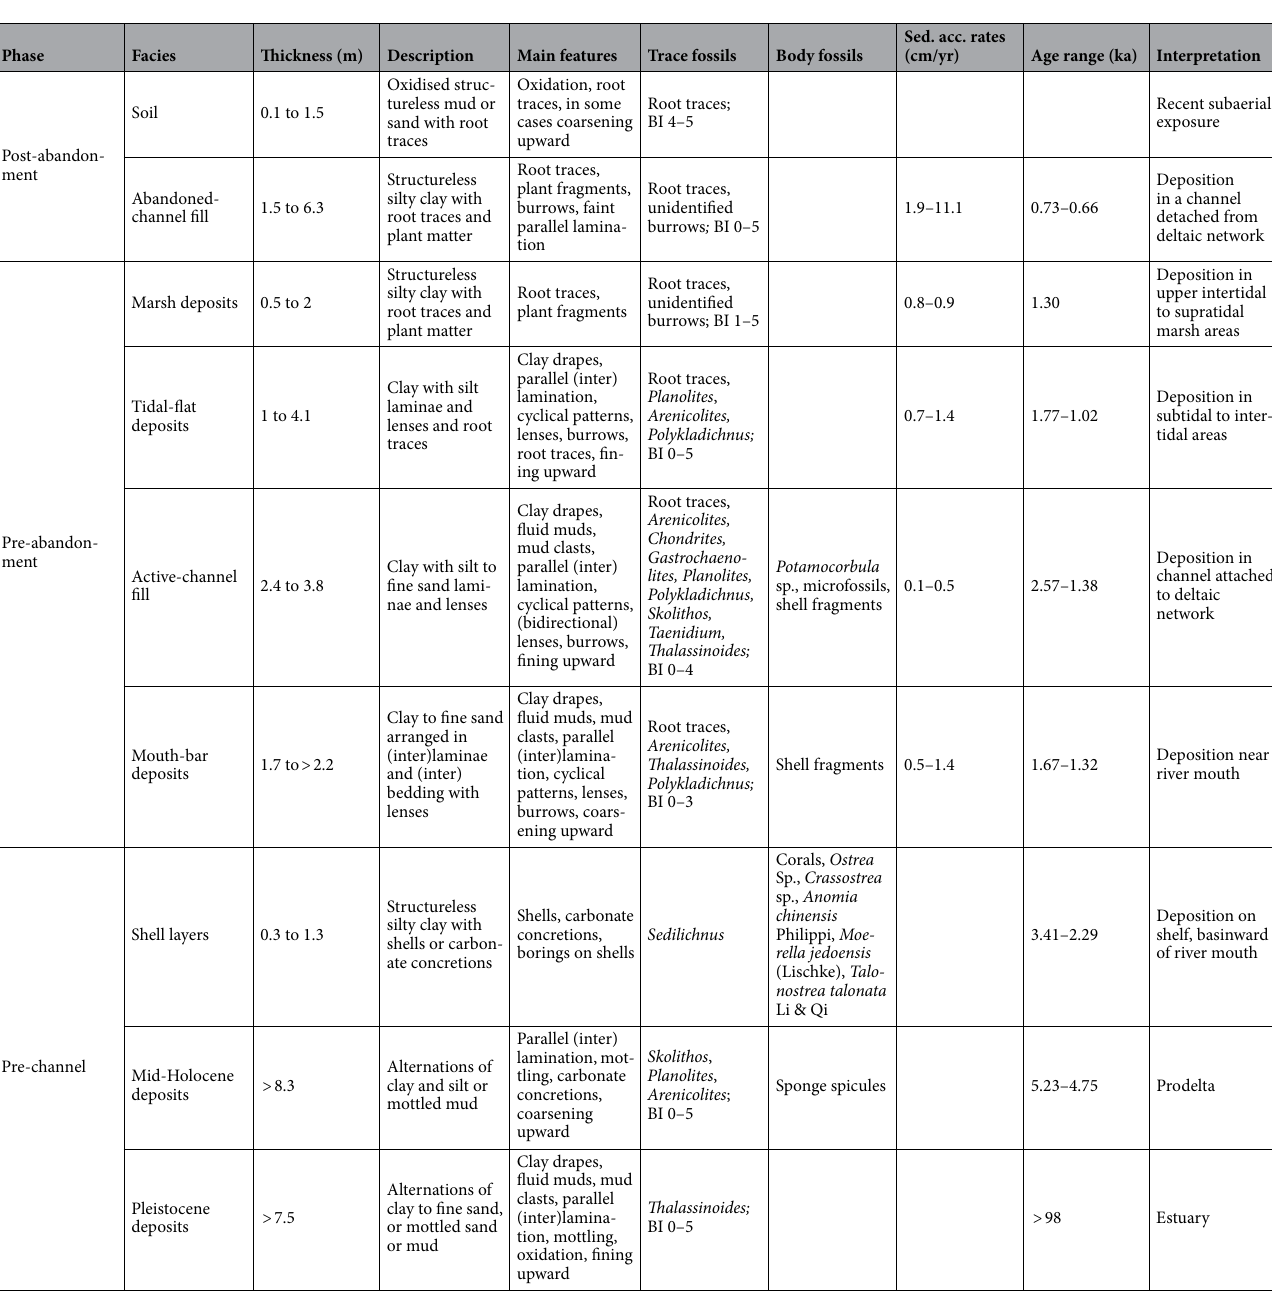
Table 1. Characteristics of the sedimentary facies identified in this